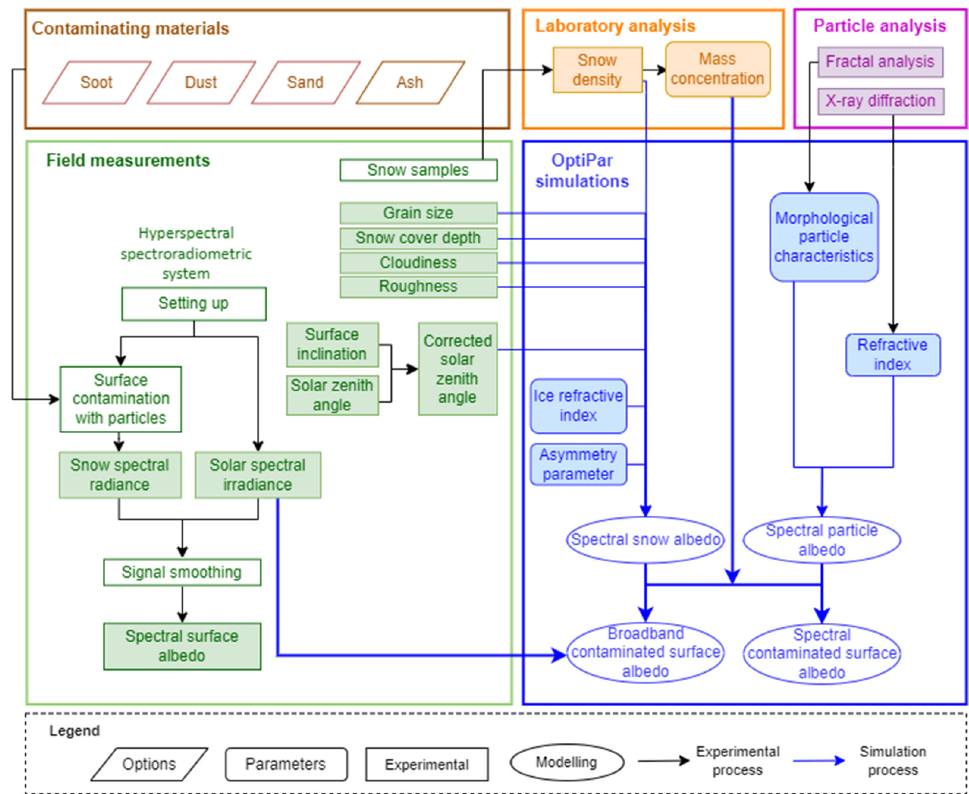
Figure 3. Scheme of the procedure and methodology followed connecting field measurements (green square) with simulations (blue), with previous laboratory analysis of particles (purple), and later snow analysis of snow (orange).